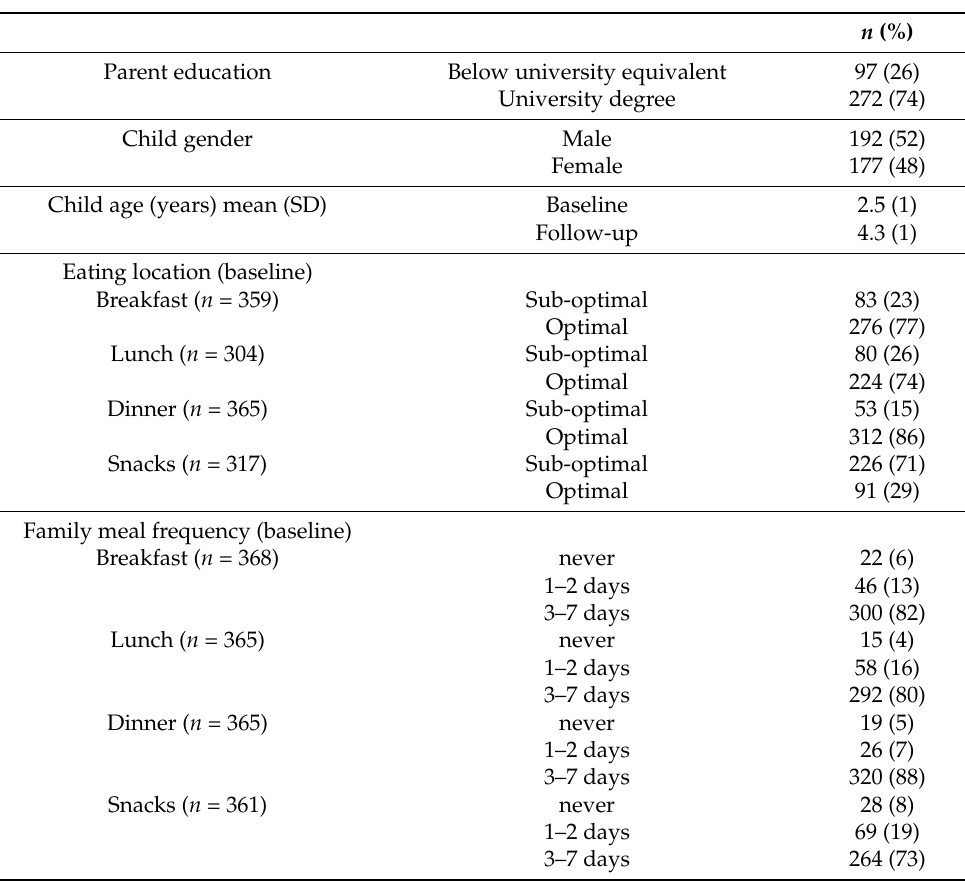
Table 1. Participant characteristics ( n =